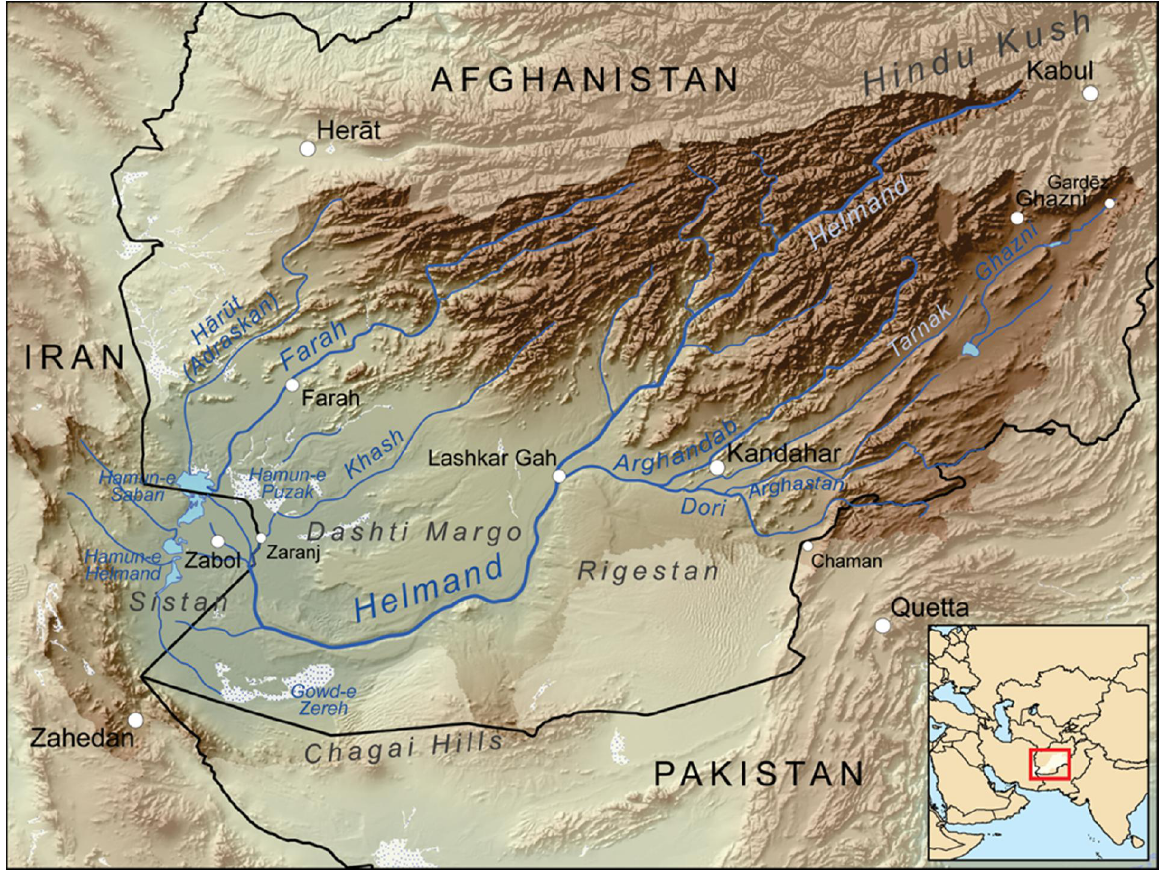
Fig. 1. Hirmand/Helmand River Basin (Source: